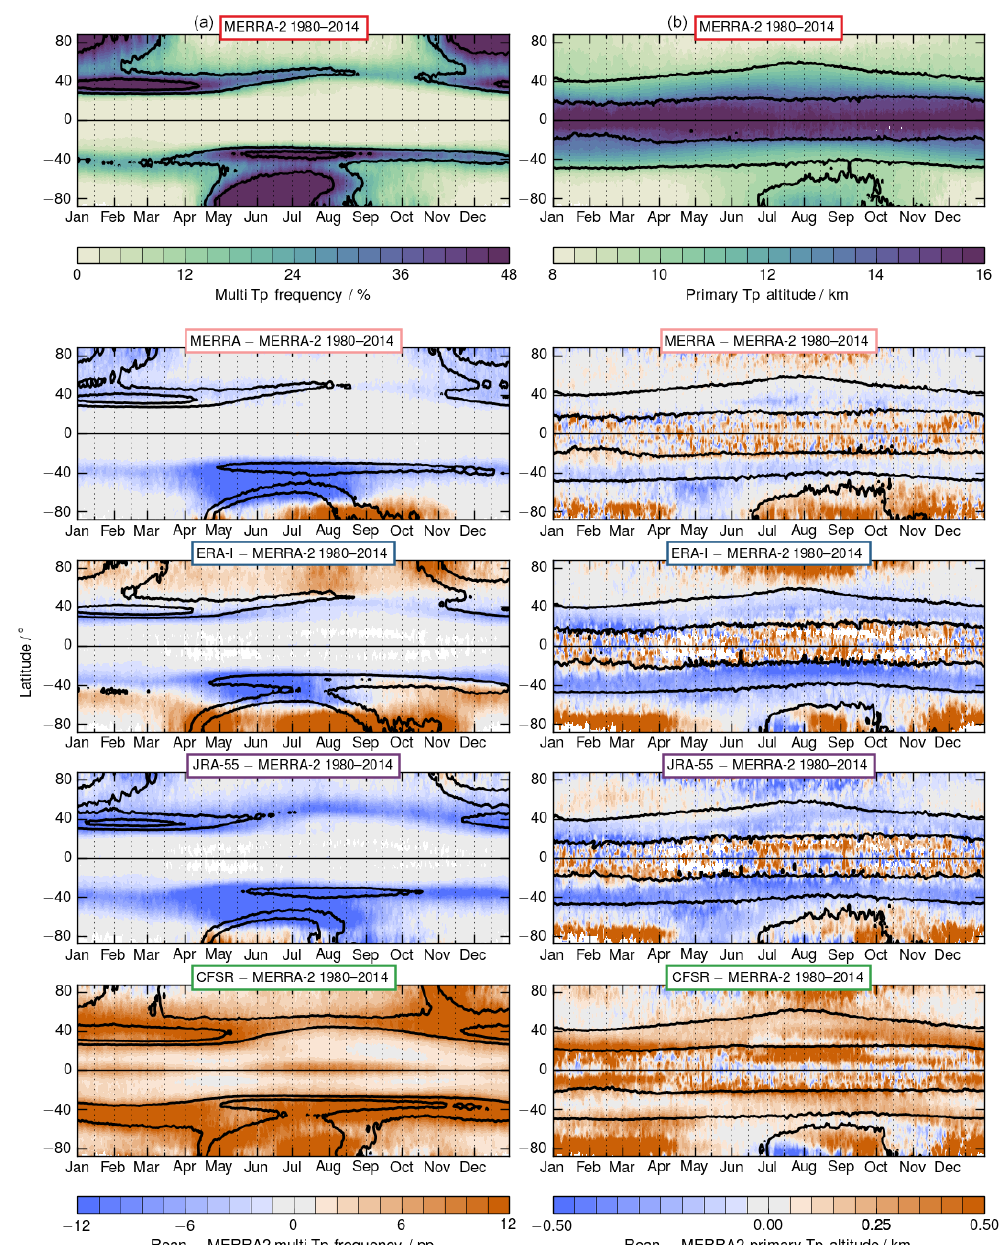
Figure 15. As in Fig. 13, but for multiple tropopauses, with frequency distributions on the left (a) and primary tropopause altitude on the right (b) . Overlaid contours are 24 and 48% for frequencies and 10 and 14km for altitudes; the smallest value is always the largest or “outermost” contour. In the difference plots, blues/oranges indicate negative/positive